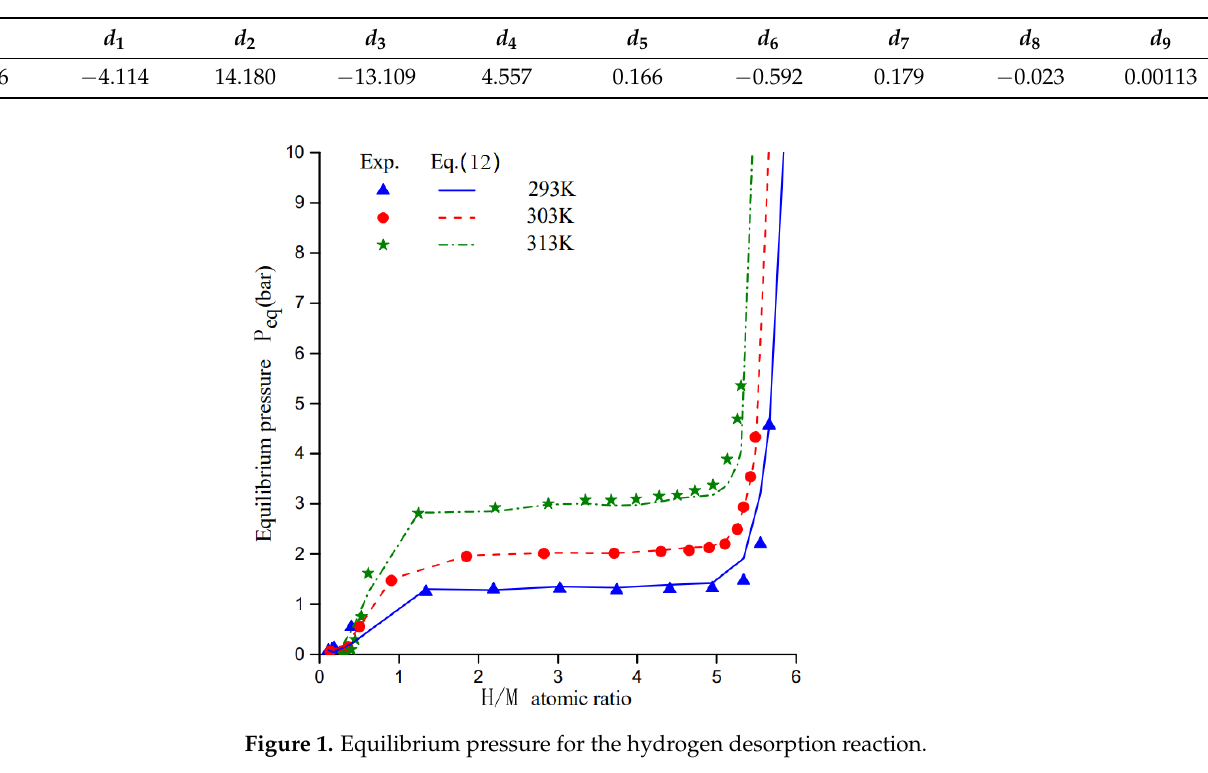
Table 1. Polynomial coefficient for Equation (12).